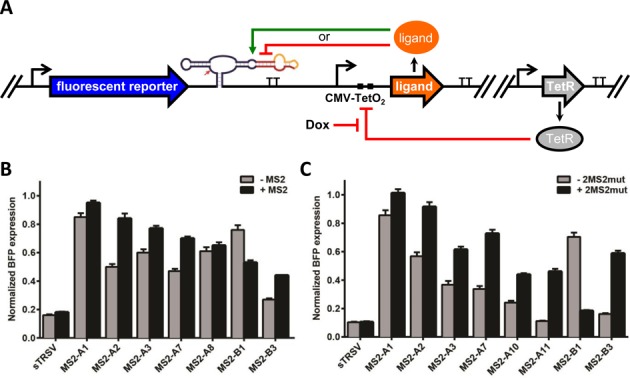
In vivo activity of protein-responsive ribozyme switches in HEK293 cells. (A) Schematic of the protein-responsive ribozyme switch characterization system for human cells. The first construct encodes the expression of the ribozyme switch in the 3′ UTR of a fluorescent reporter (BFP) from a constitutive promoter. The second construct encodes the expression of the protein ligand from a tetracycline-responsive CMV-TetO2 promoter. Both expression constructs are placed on a single plasmid, which is transfected into a Flp-In T-REx HEK293 cell line that stably expresses TetR. TetR repression is relieved by the addition of doxycycline. (B) Gene-regulatory activity of MS2-responsive ribozyme switches in human cells. Relative BFP levels are reported for transiently transfected cells harboring the indicated ribozyme switch constructs or controls in the absence and presence of MS2 (1 mg/l doxycycline). (C) Gene-regulatory activity of MS2-responsive ribozyme switches to optimized ligand in human cells. Relative BFP levels are reported for transiently transfected constructs encoding ribozyme switch sequences cotransfected with a transfection control plasmid. Reported values are the geometric mean ± SD from biological duplicates and normalized to the non-cleaving control (sTRSVctrl).